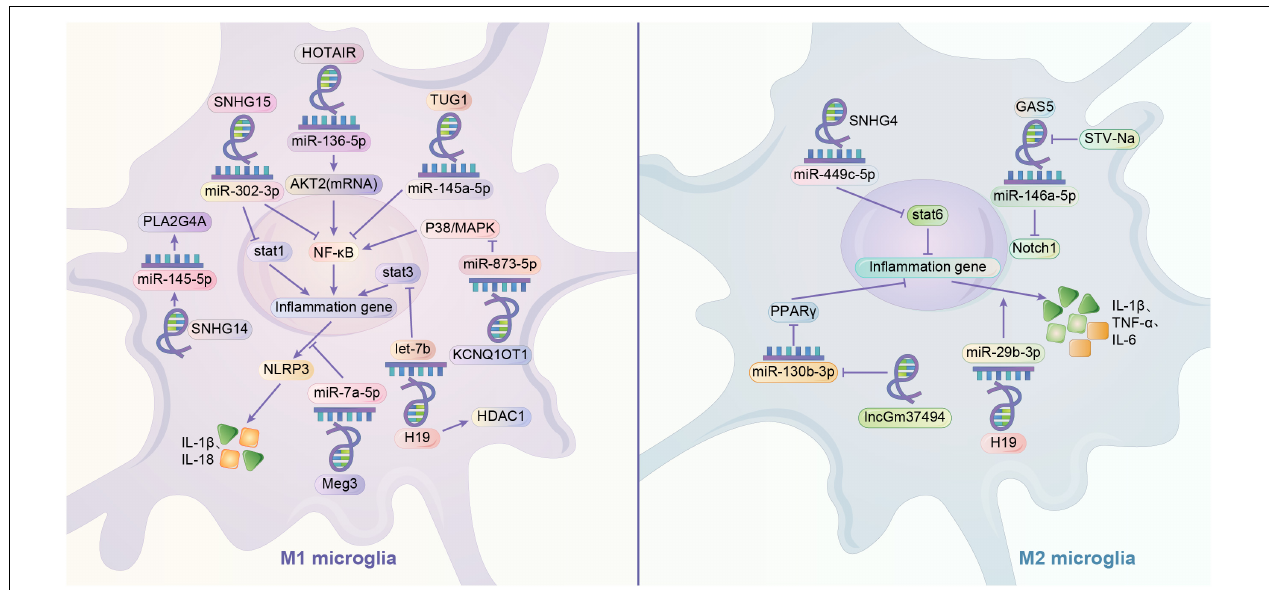
FIGURE 2 | Regulation mechanism of lncRNA/miRNA axis on microglia polarization. It is very common to see that lncRNA can play a role in regulating the microglia through mediating the miRNA, like sponging the miRNA. By sponging the miR-136-5p, HOTAIR may activate M1 phenotype by upregulating AKT2 to upregulate NF- κ B. Similarly, by sponging the miRNA, TUG1 may activate the microglia through NF- κ B. Meg3 and sponged miR-7a-5p may together upregulate the NLRP3 to promote M1 phenotype. GAS5 may increases the expression of Notch1 protein signaling through sponging miR-146a-5p to promote M1 polarization in microglia, but this influence can be disrupted by STV-Na to convert to M2. Meanwhile, one of the crucial pathways in switching the polarization of microglia is the activation of STAT family. STAT1 and STAT3 are related to M1 phenotype, while STAT6 is related to M2 phenotype. SNHG15 may promotes STAT1 and its NF- κ B expression by sponging miR-302a-3p. H19 may sponge let-7b to promote STAT3 activation, and in some cases, it might activate the M1 phenotype by increasing the HDAC1. However, H19 may also exert a promotion of M2 phenotype by sponging miR-29b-3p. Contrary to M1 phenotype, SNHG4 may promote M2 polarization in microglia and activate the STAT6 by sponging miR-449c-5p. LncRNA may downregulate the expression of miRNA. KCNQ1OT1 promotes M1 polarization in microglia by downregulating miR-873-5p to promote TRAF6 -mediated p38/MAPK pathway. SNHG14 promotes M1 phenotype by suppressing the expression of miR-145-5p on PLA2G4A. lncGm37494 promotes M2 polarization by inhibiting miR-130b-3p to promote the PPAR γ